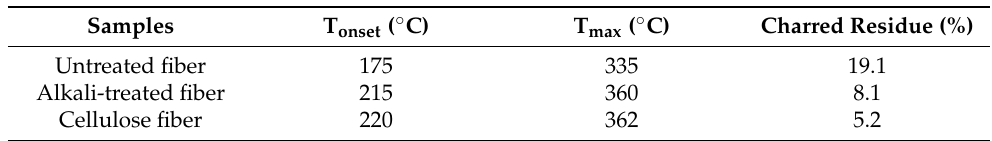
Table 4. Thermal degradation temperatures and charred residue of Ziziphus jujuba fibers before and after different treatments (10 ◦ C/min, under N 2